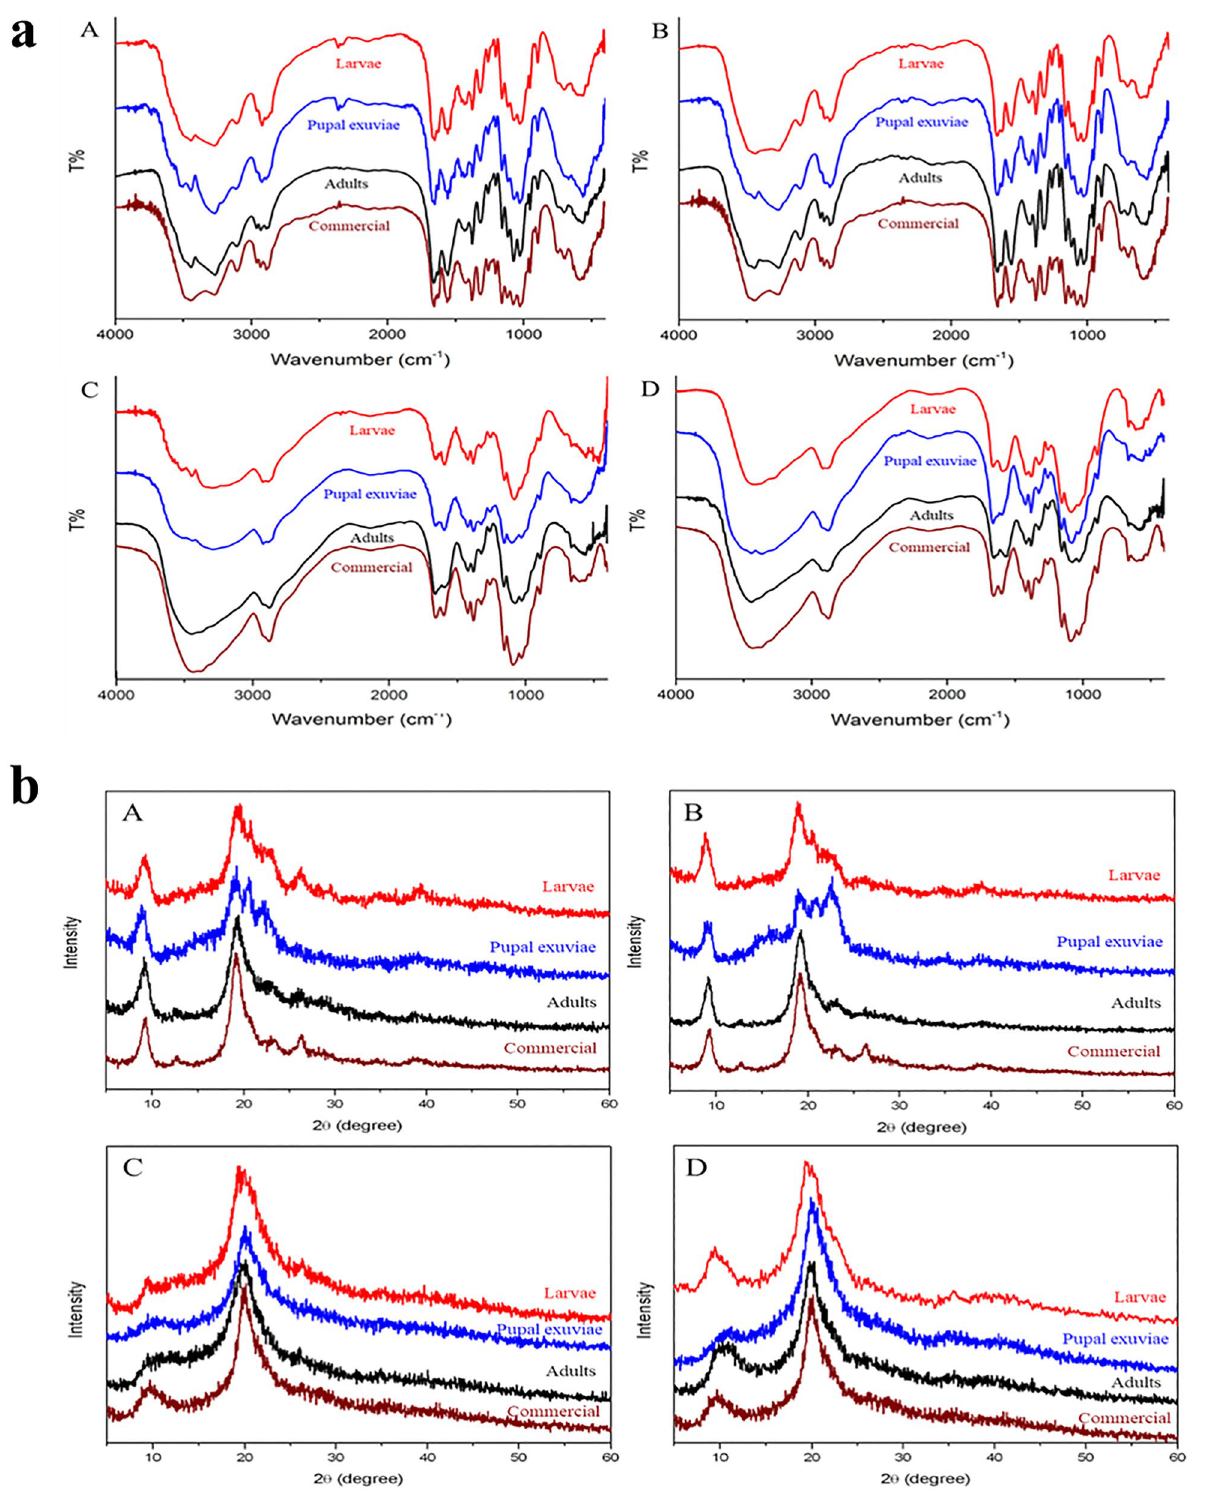
Figure 2. (a) FTIR spectra of both unbleached (A,C) and bleached (B,D) chitin (A,B) and chitosan (C,D) samples extracted from H. illucens larvae (red line), pupal exuviae (blue line) and dead adults (black line). Commercial chitin and chitosan (wine lines) derived from crustaceans also are reported. (b) XRD spectra of both unbleached (A,C) and bleached (B,D) chitin (A,B) and chitosan (C,D) samples extracted from H. illucens larvae (red line), pupal exuviae (blue line) and dead adults (black line). Commercial chitin and chitosan (wine lines) derived from crustaceans are also